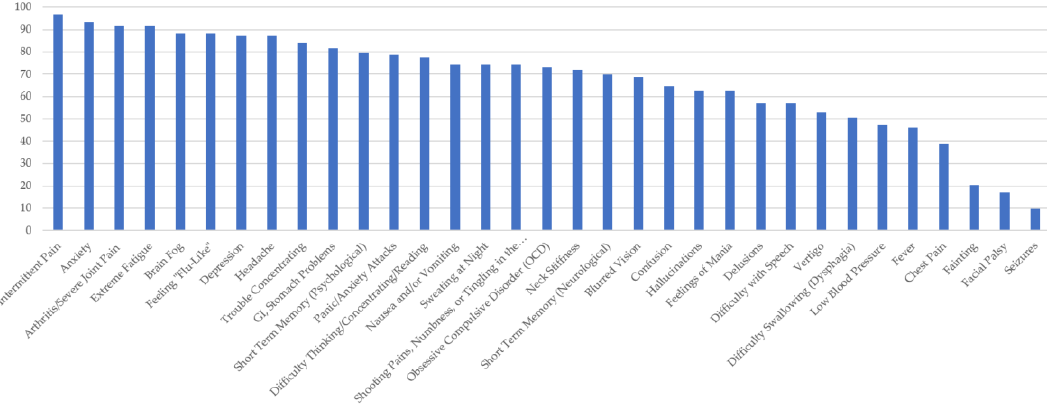
Figure 4. Percentage of Respondents with Lyme disease Reporting Specific Symptoms.